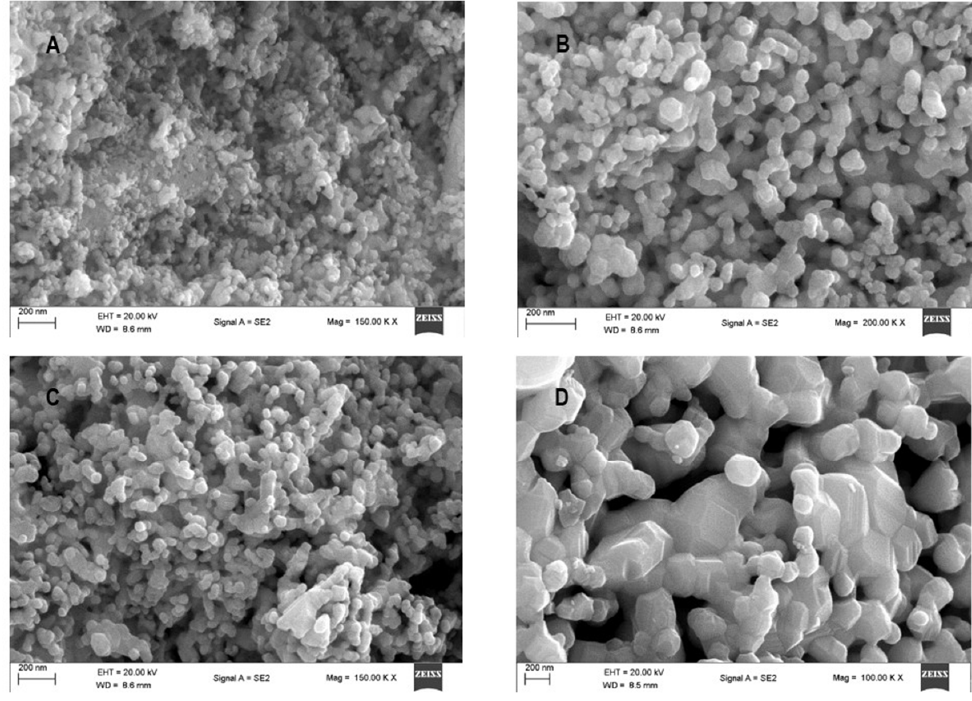
Figure 5. SEM micrographs of LM 700 ( A ), LM 800 ( B ), LM 900 ( C ), and LM 1000 ( D ).